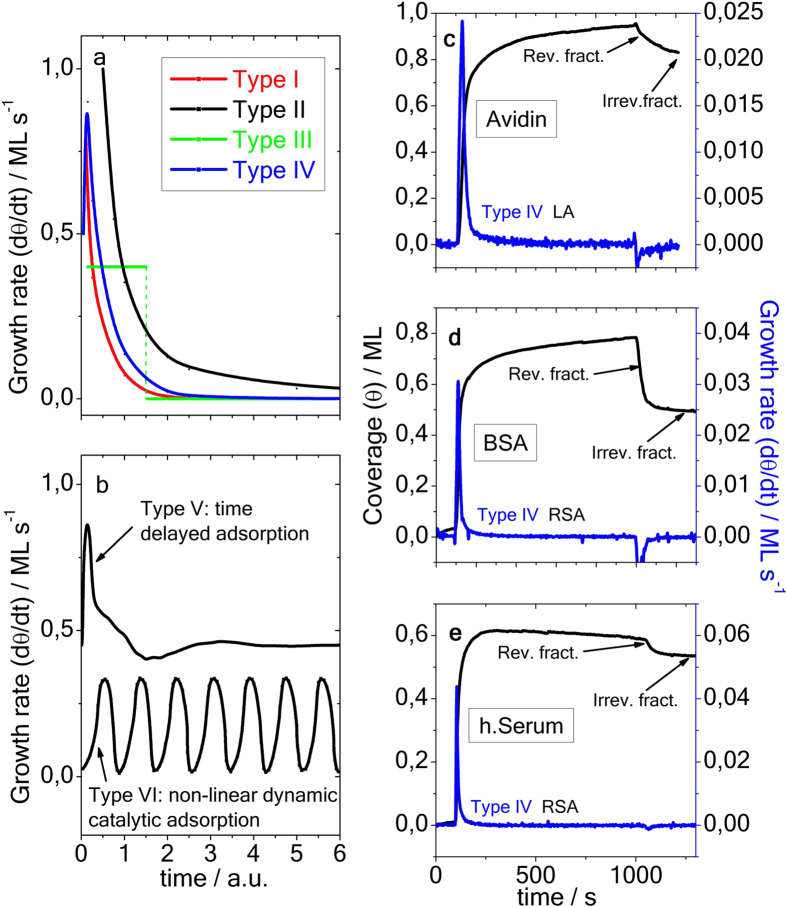
Sketch of the temporal evolution of growth rates dθ(t)/dt for 6 different molecular binding models (a,b) and experimentally obtained protein adsorption transients for avidin, BSA and human Serum (c–e)20, as indicated in the figure. Type I: Irreversible Langmuir type binding8; type II: Random sequential (irreversible) adsorption (RSA)12; type III: generalized refined RSA type models13141516; type IV: the generalized molecular kinetic model10; type V: the kinetic model with time delay1819; type VI: catalytic non-linear dynamic model123.